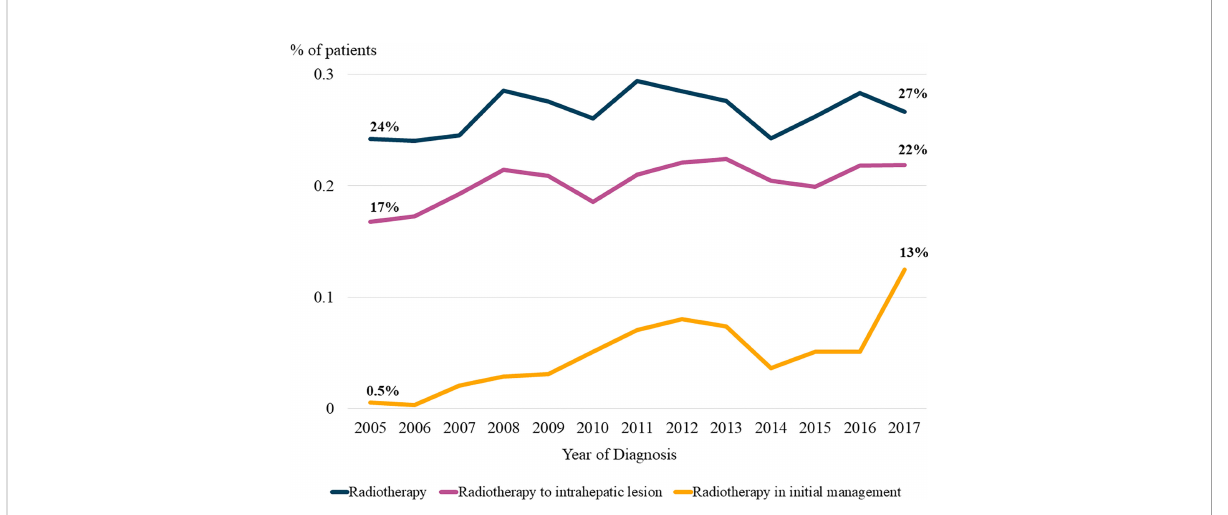
FIGURE 1 Trends in the radiotherapy utilization rate. The proportions of patients in the registry who received radiotherapy based on the year of diagnosis are plotted in line